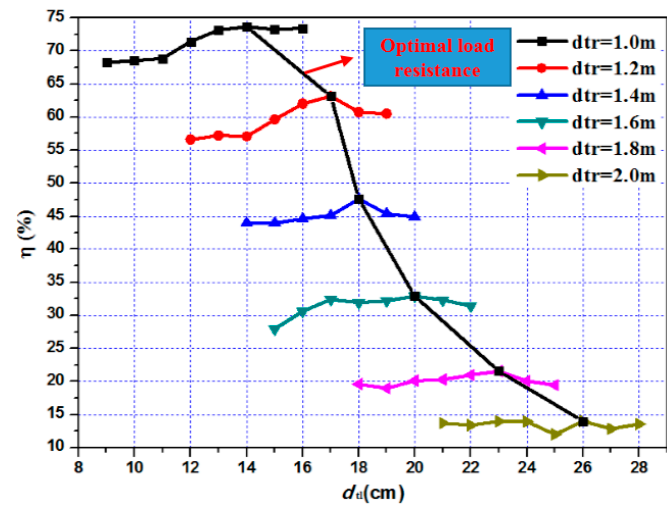
Figure 12. The experiment of the optimal load analysis. Table 4. Measured power results of the WPT system with the MMs.